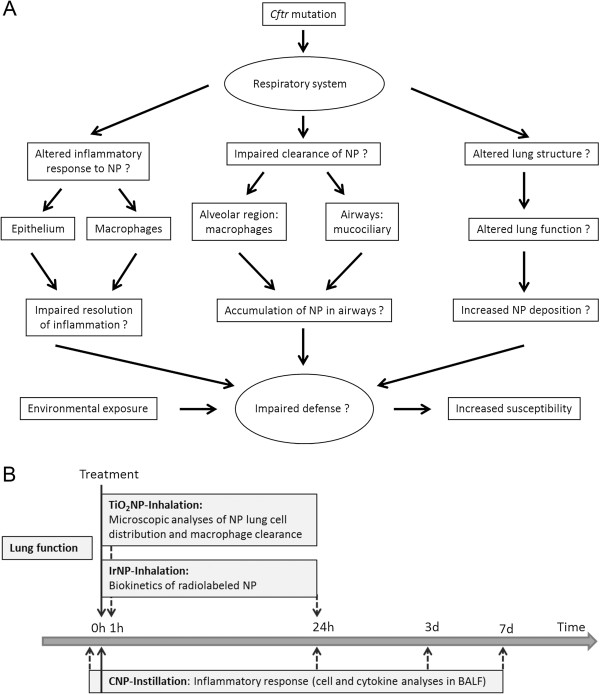
Study motivation and experimental design. A) Individual factors and multifactorial aspects for enhanced susceptibility of CF lungs to PM exposure. B) Time frame for lung function measurements, treatments with NP and subsequent analyses. CNP-Instillation: intratracheal instillation of carbon nanoparticles; BALF: Bronchoalveolar lavage fluid.